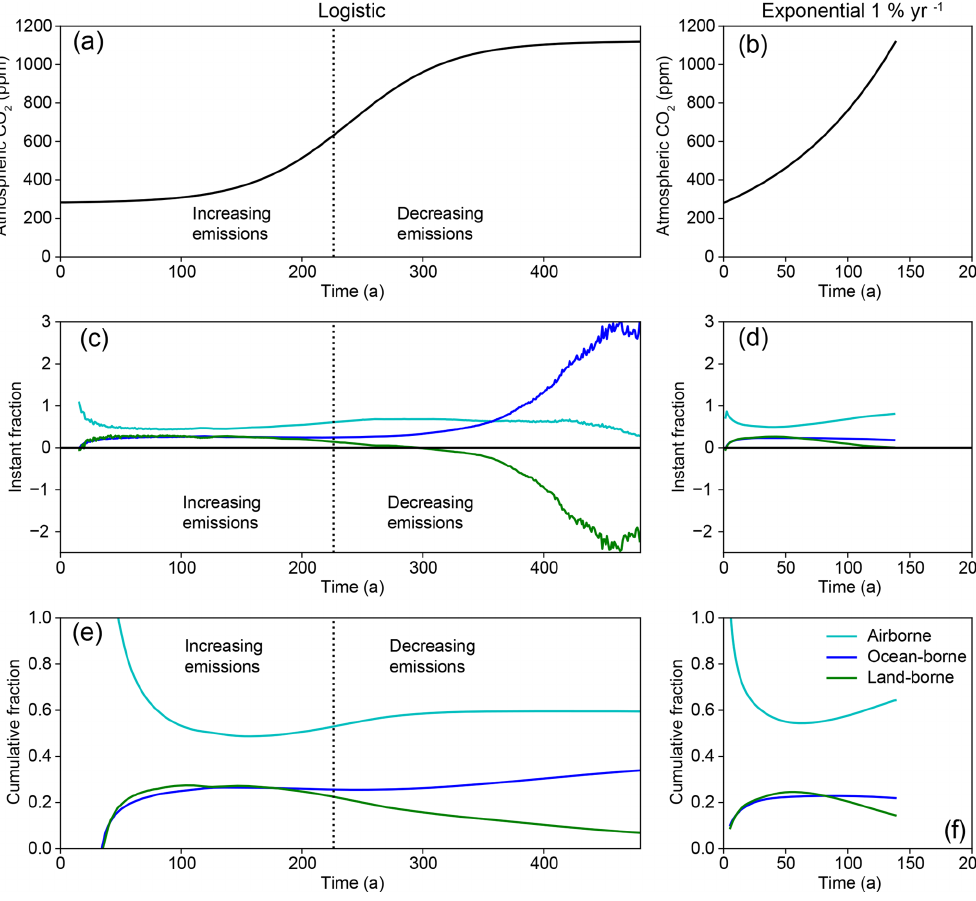
Figure 4. CO 2 concentration (a, b) , instantaneous carbon fractions (c, d) , and cumulative carbon fractions (e, f) for the 4 × CO 2 logistic and 1%